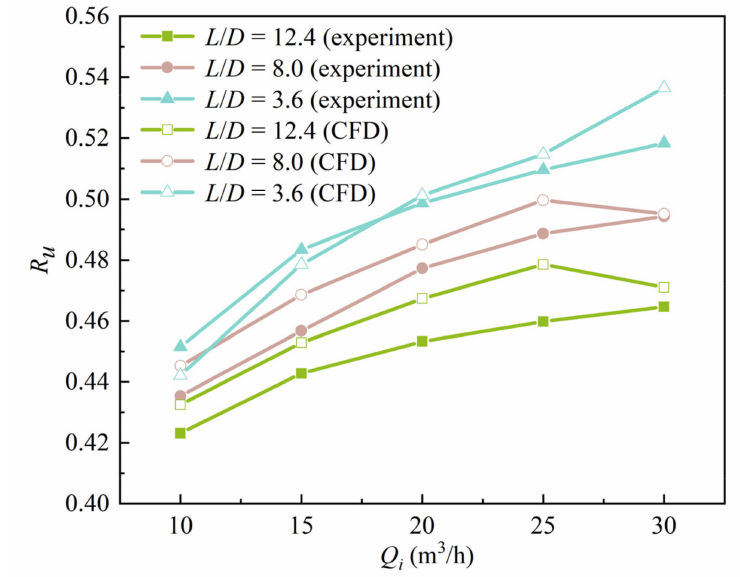
Figure 3. Splitting Ratio of Experiment and CFD Simulation.